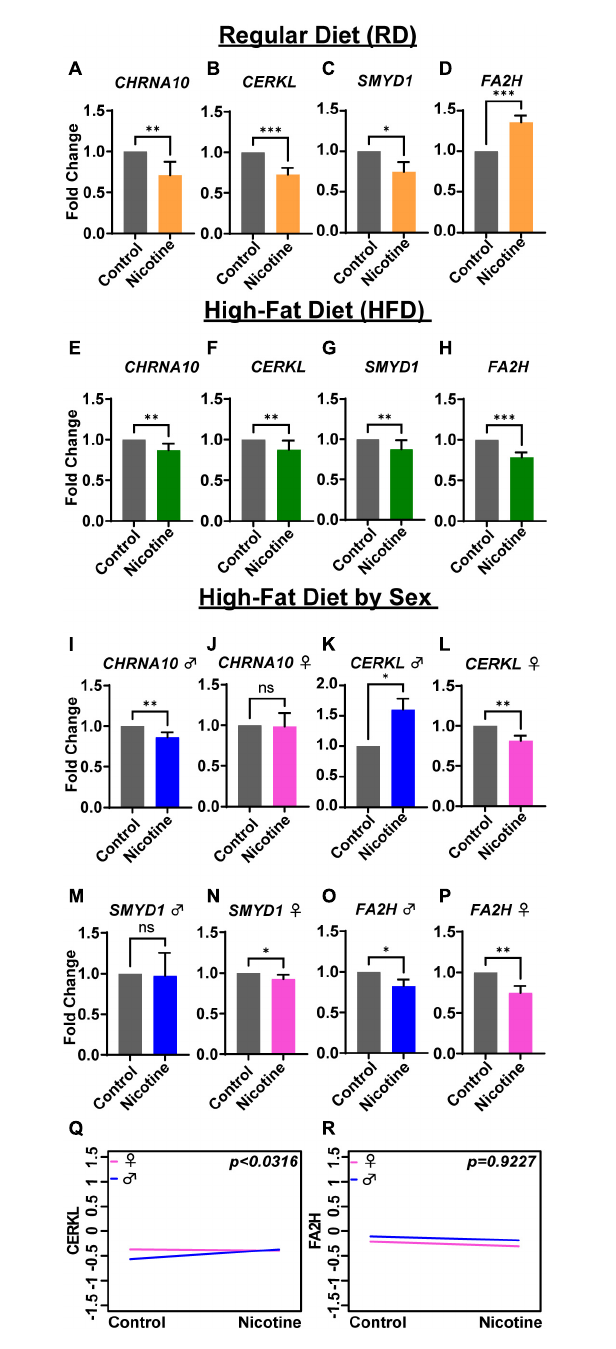
FIGURE3 Diet- and sex-depending differences in gene expression levels in rats. Gene expression by fold change is shown for rats under a regular diet (yellow bars) (A–D) , high-fat diet (green bars) (E–H) , and high-fat by sex: male (blue bar) and female (pink bar) (I–P) . ANCOVA analysis showed sex differences between males and females for the CERKL gene (Q) , but not for FA2H (R) . Each bar represents the mean ± SEM of six rats; ns, no significant; ∗ p < 0.05; ∗∗ p < 0.01, ∗∗∗ p < 0.001 ( t